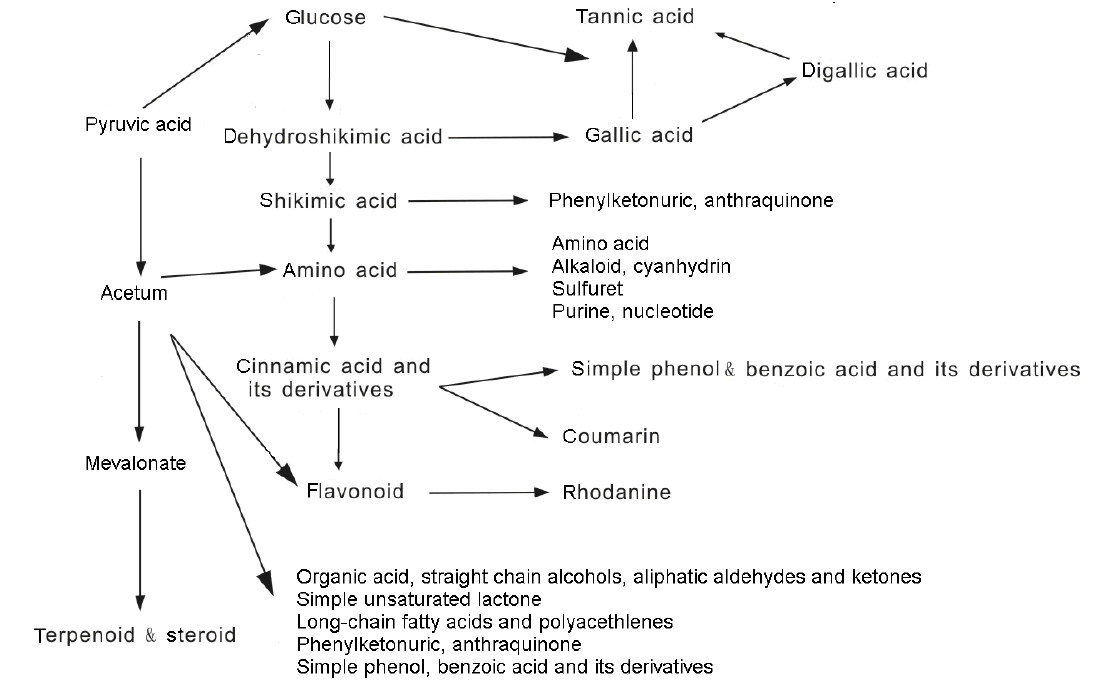
Figure1. Biosynthetic pathways of major allelopathic substances